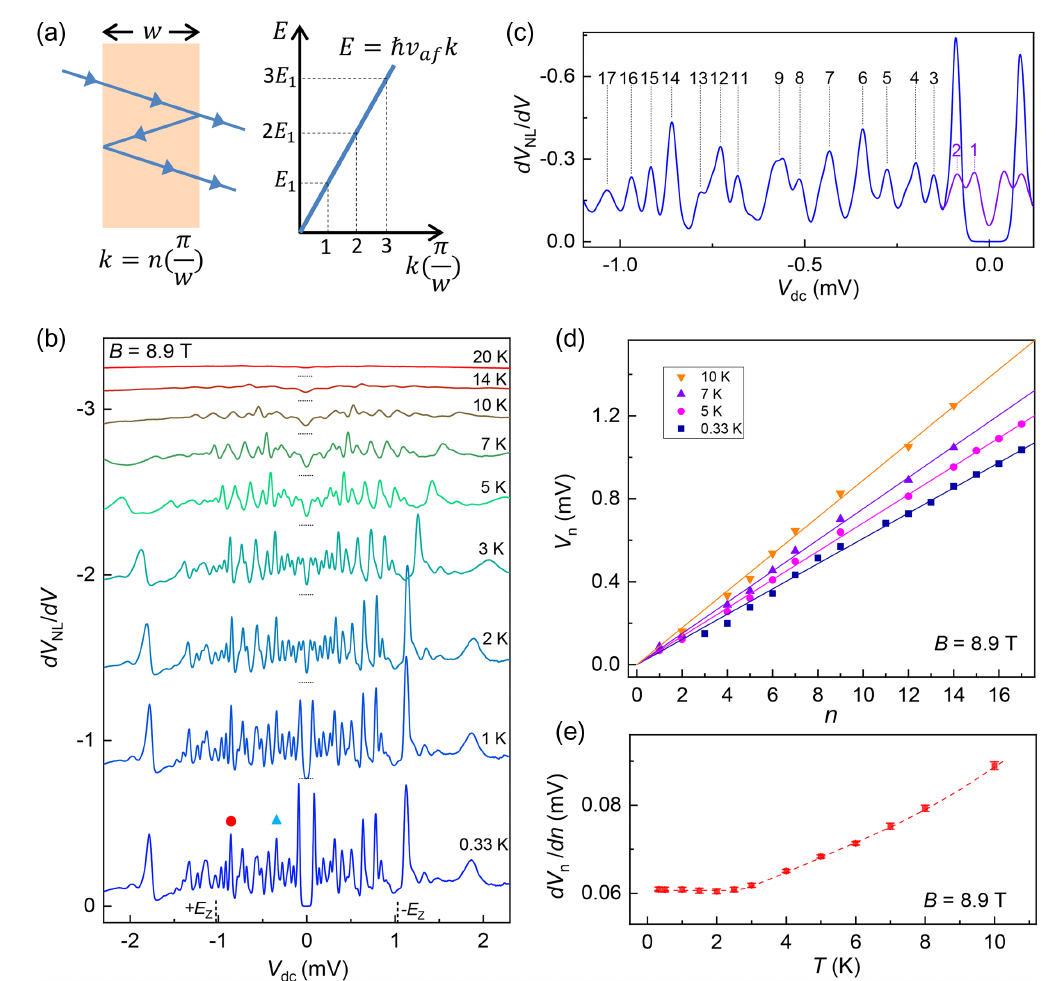
=dV vs V of a linearly dispersed SW. (b) dV at selected temperatures. Traces are vertically stacked for clarity. Short black dashed NL dc =dV at T ¼ 0 . 33 K (blue) and 2 K (purple) with the mode numbers lines mark the zero-signal position of each trace. (c) plots dV NL l < 0 . 23 for the entire range. The n ¼ 1 and 2 modes are suppressed at labeled in the plot. We probe the long wavelength limit where k n B low temperatures, likely due to a small contact barrier [Fig. 14(a) in Appendix E]. Irregularities of the oscillations are attributed to nonuniformity of the cavity, similar to Ref. [46]. (d) V vs mode number n at selected temperatures. Solid lines are fits to data that pass n through the origin. Free parameter fitting yields y -axis intercepts less than 1 = 2 E 1 at all temperatures. (e) plots the T dependence of the =dn extracted from the fitting. B ¼ 8 . 9 T in all figures. From 606. An analysis of the FP resonance in device 611 is given slope dV n